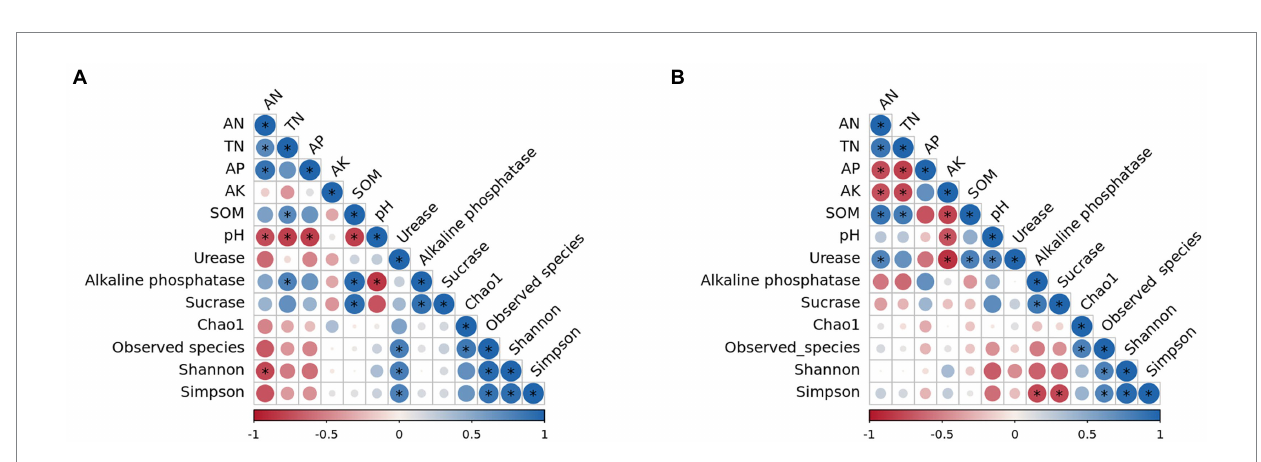
FIGURE 8 Correlation analysis of soil nutrients, enzyme activities and diversity index. (A) 0–10 cm; (B) 10–20 cm. * p <